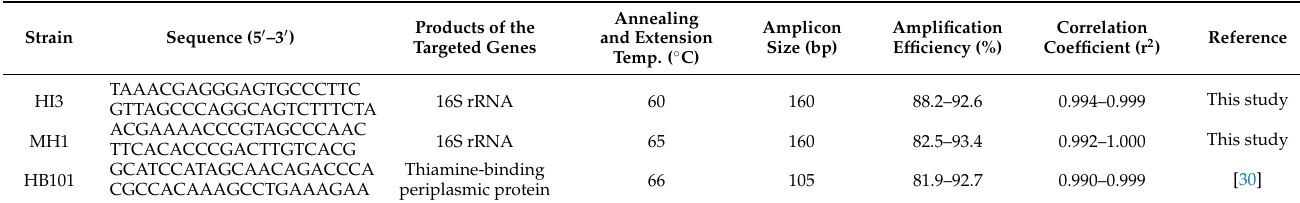
Table 1. Primers used for qPCR analysis.